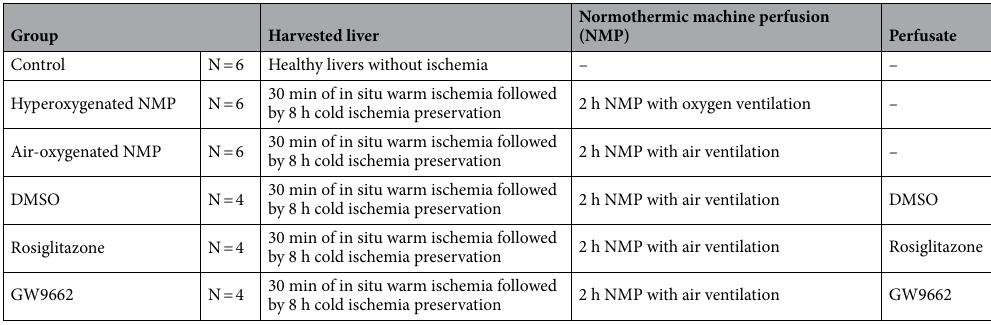
Table 1. Design of animal experiment (N =